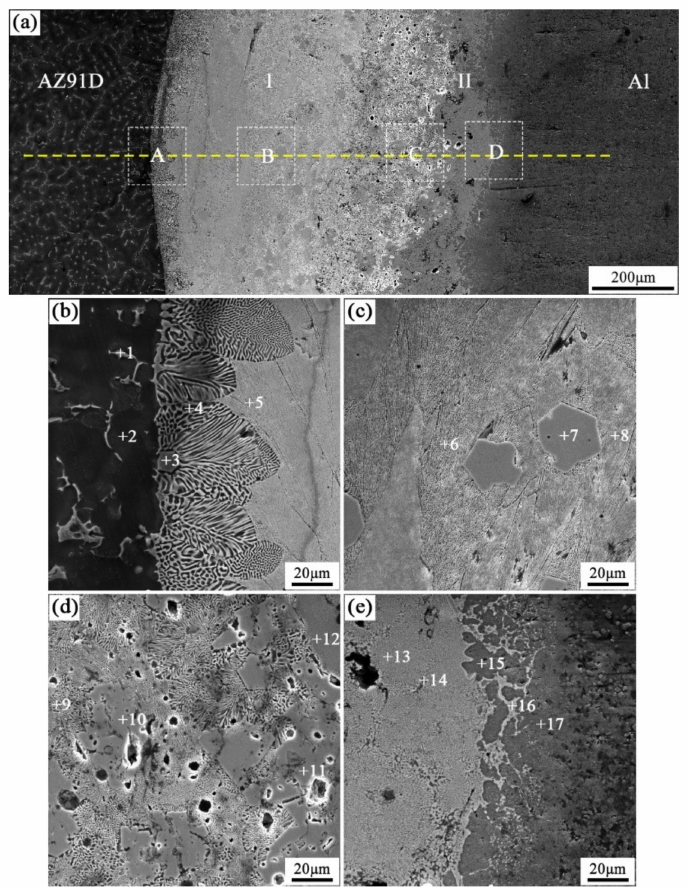
Figure 6. SEM micrographs of the interface in arc-sprayed Al / AZ91D with a Zn interlayer (arc-spraying Zn for 18 s and Al / Zn double-deck coating preheated for 12 h): ( a ) general view, ( b – e ) areas A, B, C, and D in ( a ), respectively. Table 5. EDS analysis results corresponding to the points marked in Figure 6. Point